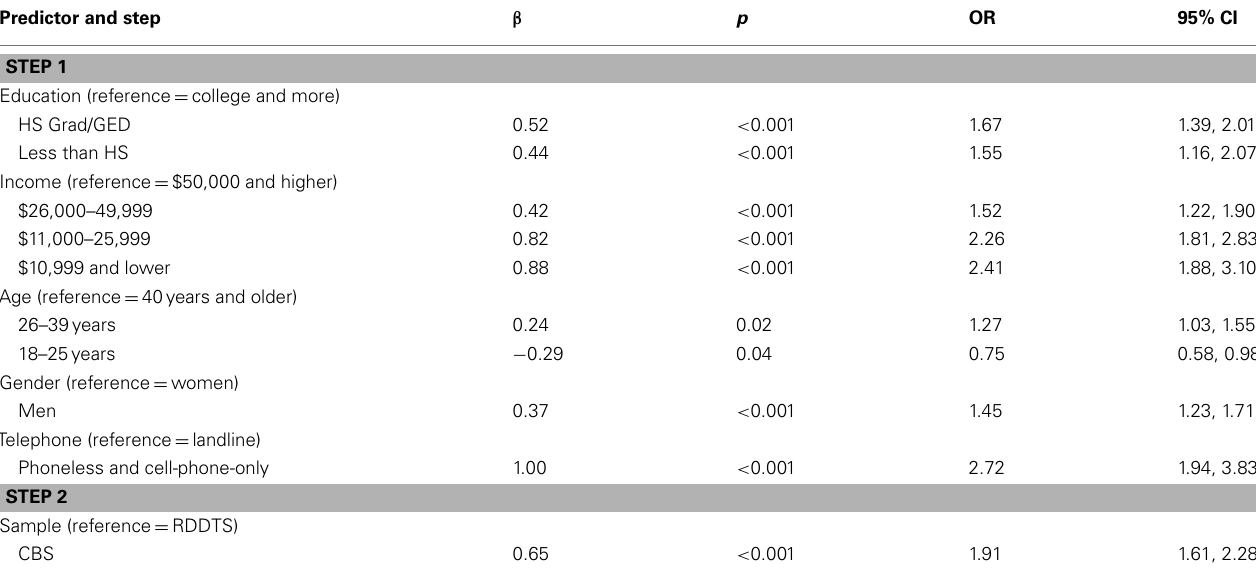
Table 3 | Logistic regression predicting smoking among CBS and RDDTS